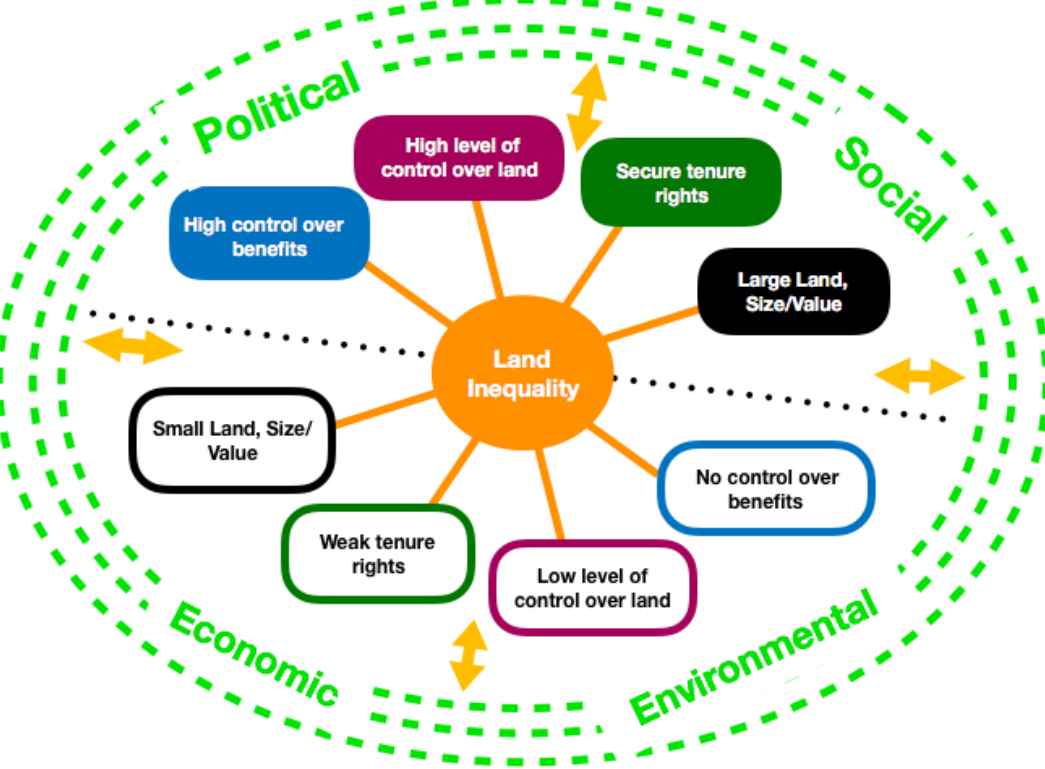
Figure 1. Land and inequality conceptualized (Source: the authors).